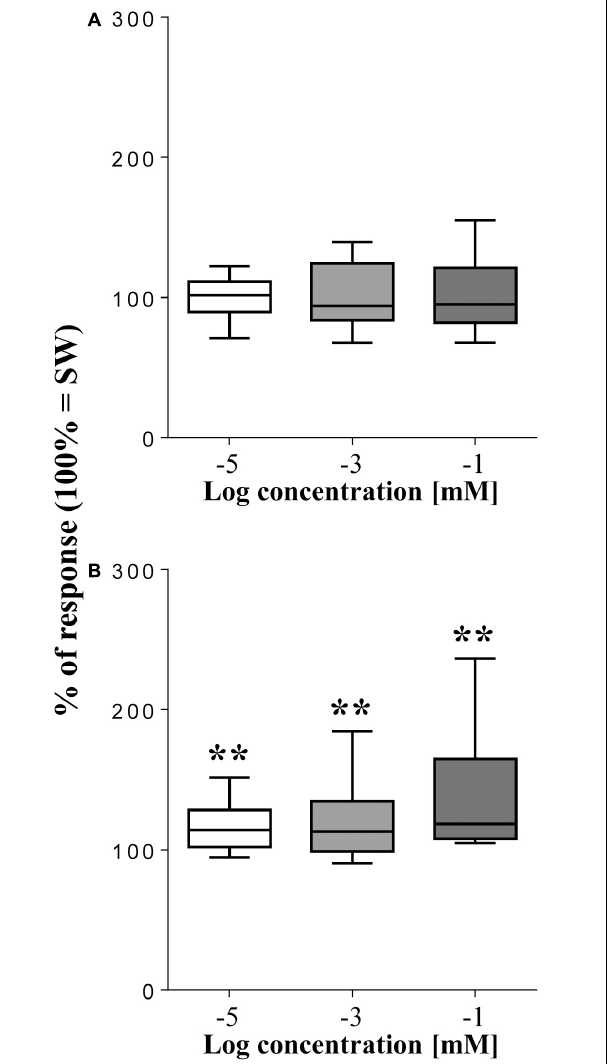
FIGURE 3 | Normalized movement rate of sea urchins, recorded as mean square difference in light intensity (summed peak heights for each preparation during a 2-min stimulation) ± se (vertical bars), following supply of the monosaccharides fructose (A) and glucose (B) compared to seawater (SW = 100% of response). The top and bottom of the box and whisker plots show the upper and lower quartiles, respectively. The horizontal line in the middle indicates the median of the corresponding distribution, while the minimum and maximum observed values are indicated by the bars connected to the box. ∗∗ indicates a significant difference ( p < 0.01, T -test) with respect to SW. Data were obtained from 15 sea urchins for both fructose and